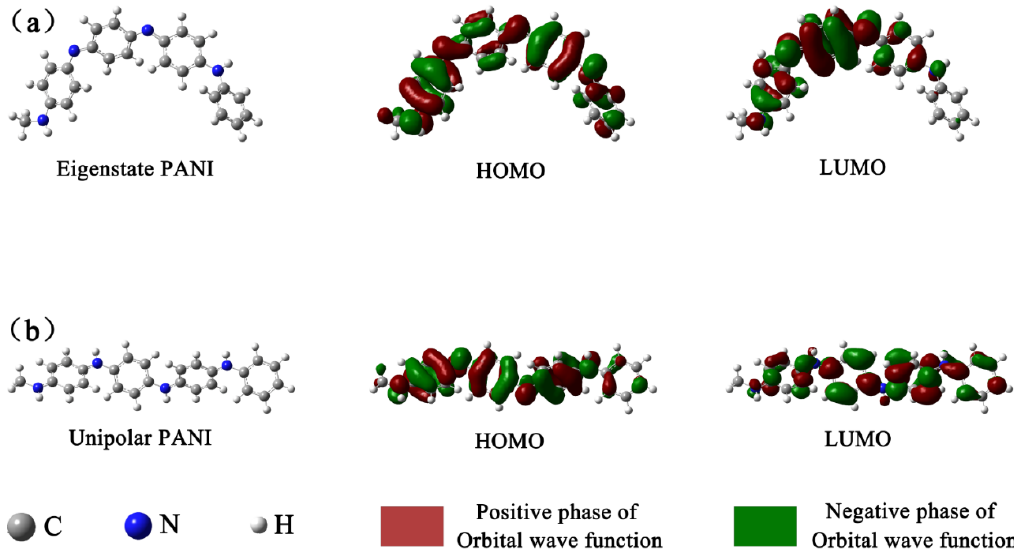
Figure 8. ( a ) DFT calculations of the FMOs of the eigenstate PANI unit. ( b ) DFT calculations of the FMOs of the unipolar PANI unit.